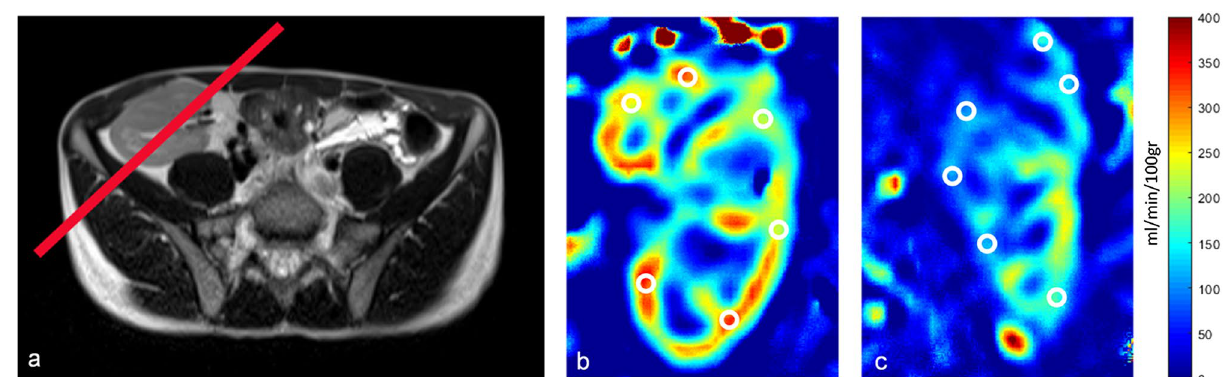
Figure 5. ( a ) Positioning of the middle slice; ( b ) Quantitative Perfusion Map representing cRBF (ml/min/100 g) imaged in a patient with good allograft function (GFR ≥ 60 ml/min/100 g) and ( c ) Quantitative Perfusion Map representing cRBF (ml/min/100 g) imaged in a patient with impaired allograft function (GFR < 60 ml/ min/100